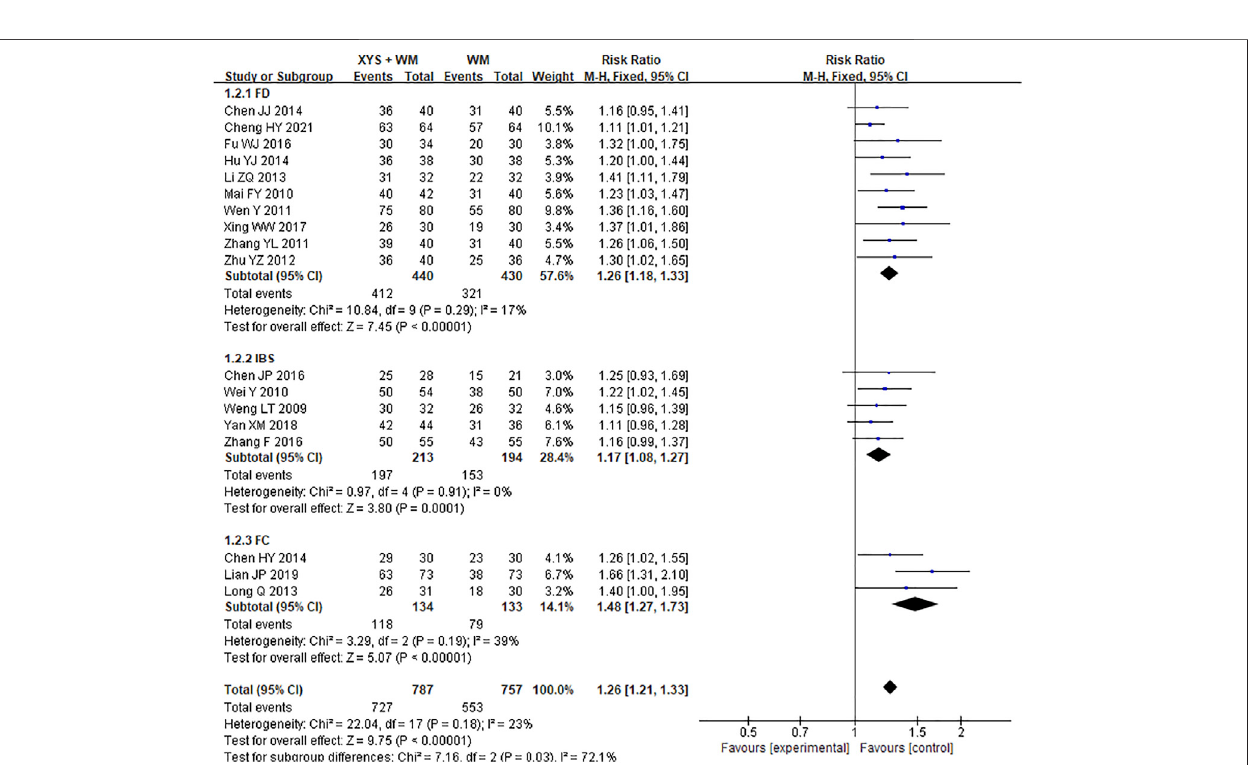
FIGURE 3 | Forest plot of comparison of ef fi cacy: XYS combined with western medicine as an adjuvant to western medicine for FGIDs. WM, western medicine.